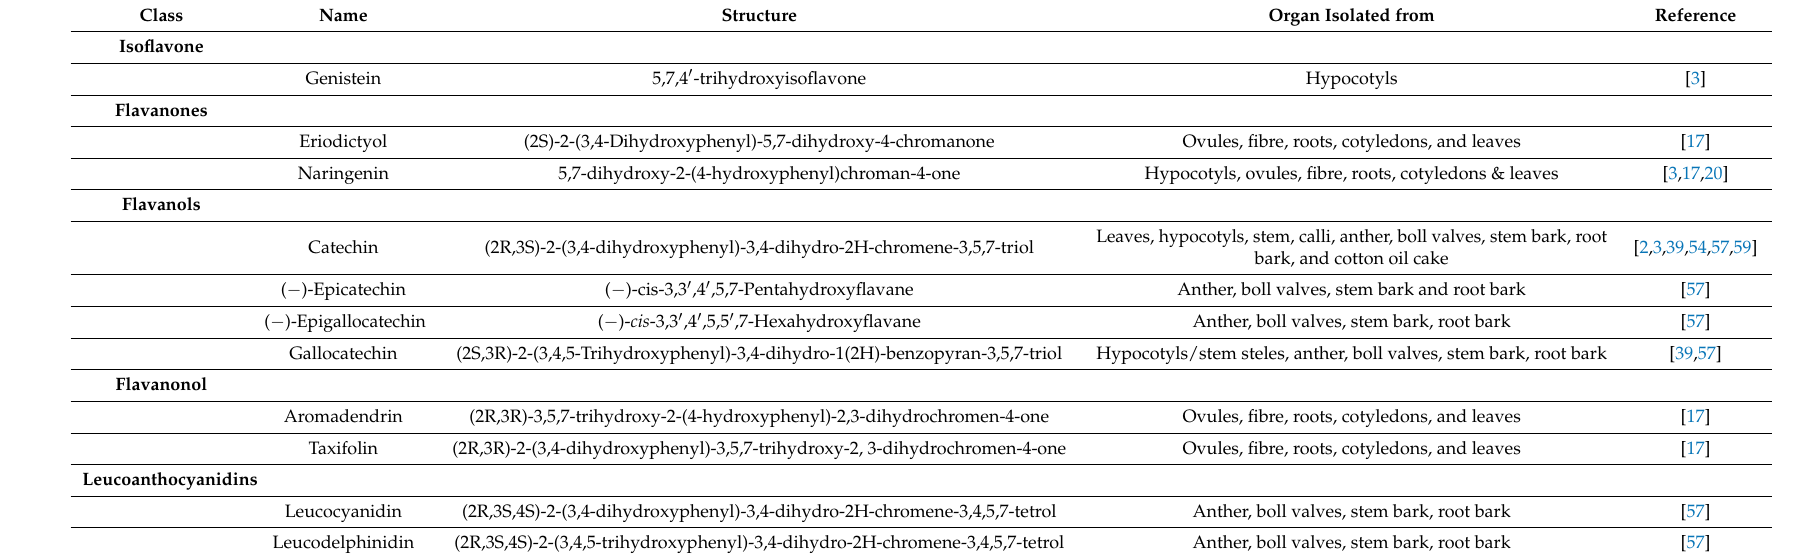
Table 4. Other flavonoids reported from Gossypium hirsutum